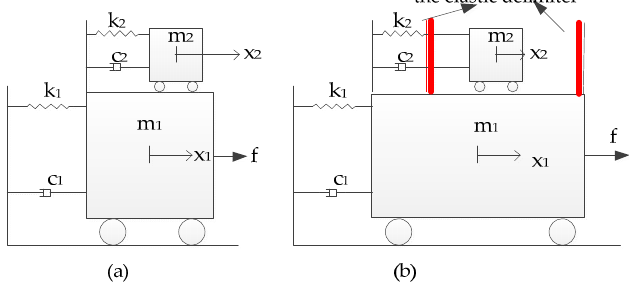
Figure 1. Schematic of ( a ) tuned mass damper (TMD); ( b ) pounding tuned mass damper (PTMD).